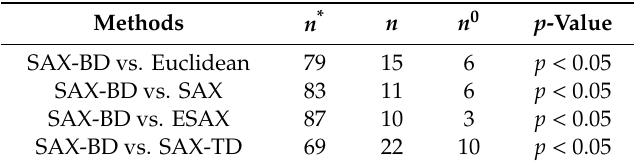
Table 4. The Wilcoxon signed ranks test results of the SAX-BD vs. other methods. A p -value less than or equal to 0.05 indicates a significant improvement. n * means positive, n means equal and n 0 means negative. The larger the value of n *, the better performance of SAX-TD.